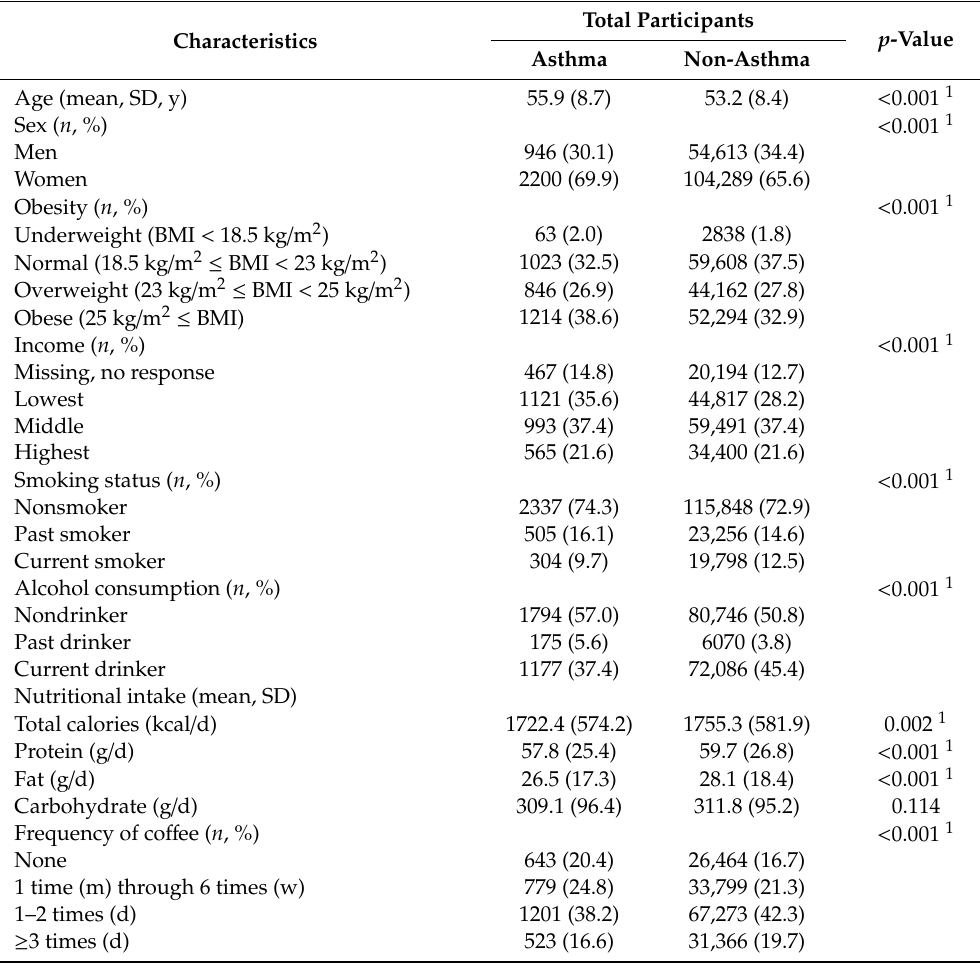
Table 1. General characteristics of the